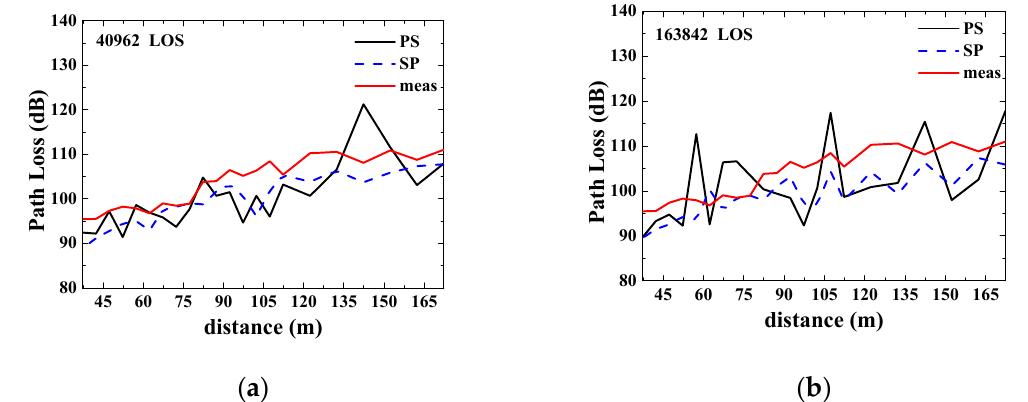
Figure 8. Path loss comparison of theoretical calculation with measured data for 40,962 and 163,842 rays in the LOS, respectively. ( a ) The number of rays is 40,962 ( b ) The number of rays is 163,842.